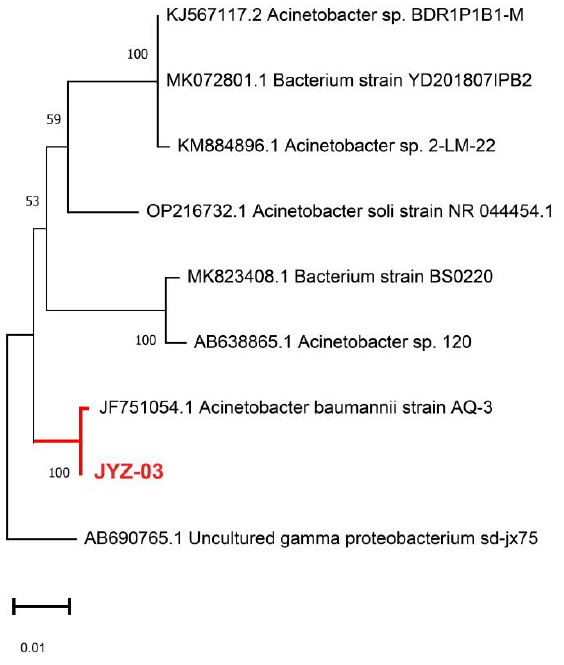
Figure 2. Phylogenetic tree of soil bacterial strains capable of degrading total petroleum hydrocarbons.